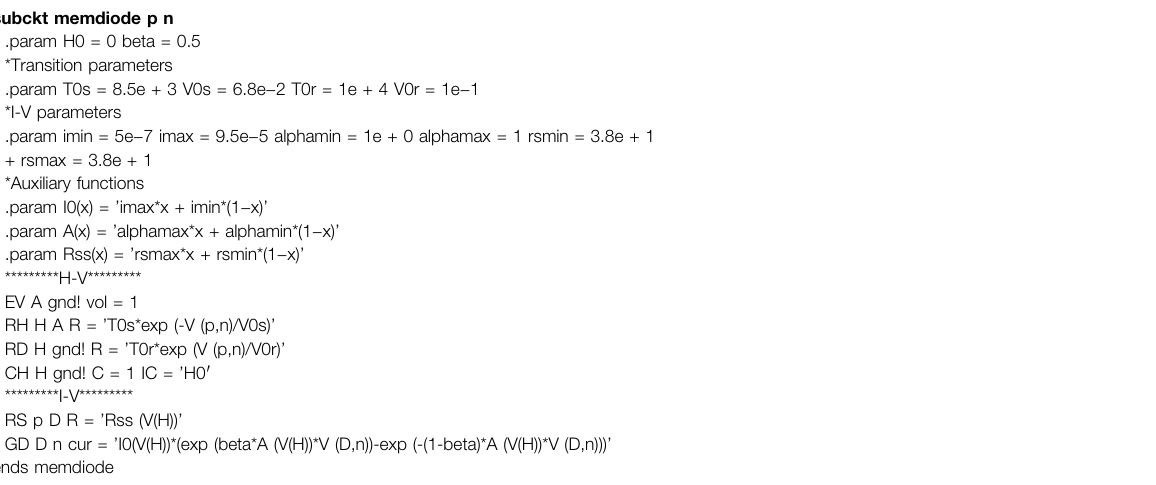
TABLE 1 | Dynamic memdiode model SPICE